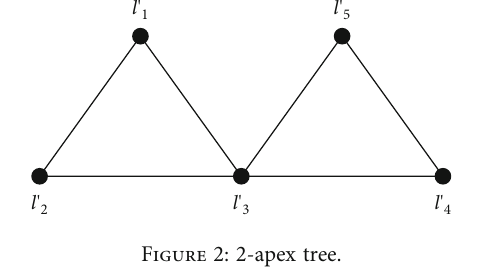
Figure 2: 2-apex